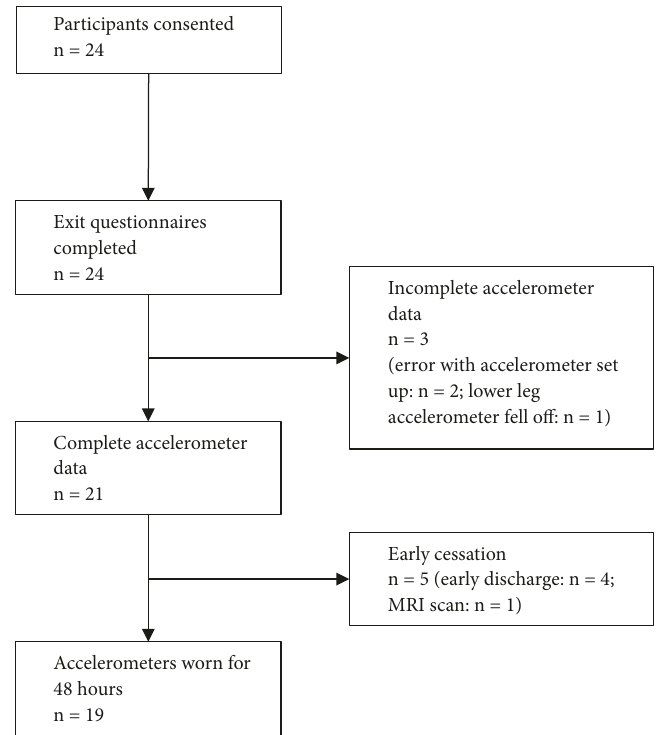
Figure 3: Flow of participants through study.